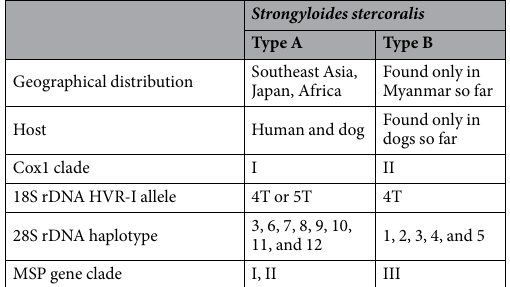
Table 7. Tentative classification of Strongyloides stercoralis and their